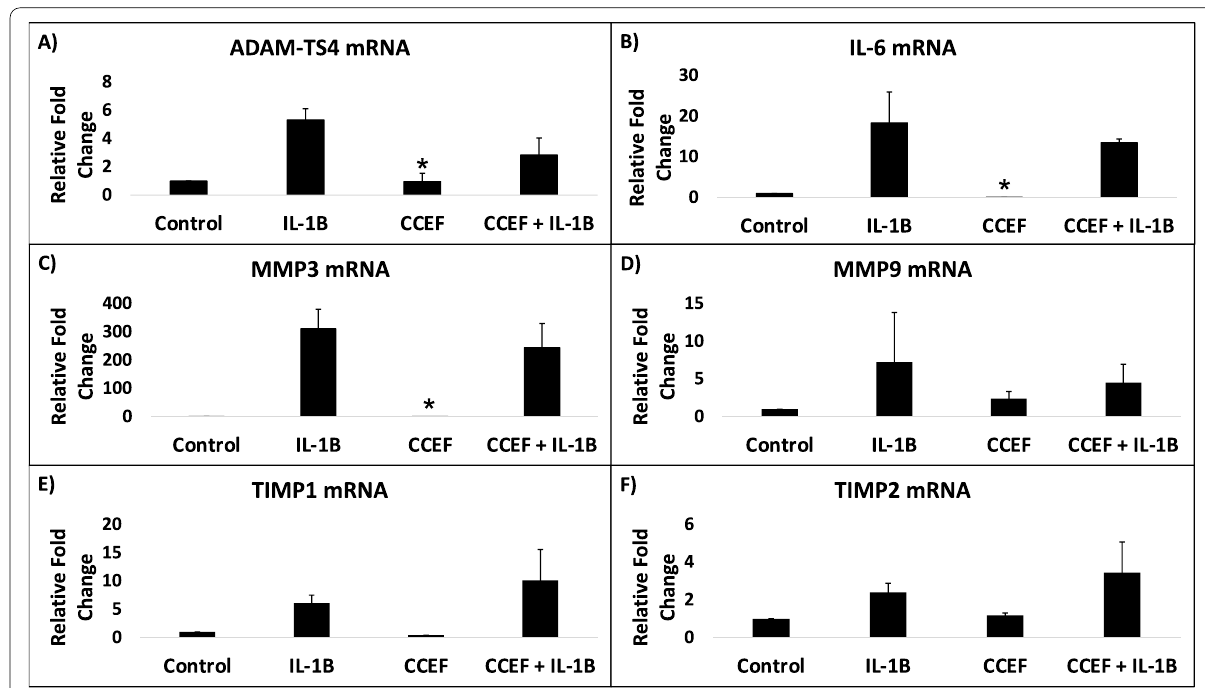
Fig. 2 Gene Expression of Rabbit Hyaline Chondrocytes. Effect of CCEF stimulation of rabbit hyaline chondrocytes in the absence or presence of IL‑1B for one week on gene expression of A ADAM‑TS4, B IL‑6, C MMP3, D MMP9, E TIMP1, and F TIMP2. A statistically significant difference ( p < 0.05) from the IL‑1B treatment group is denoted by an asterisk =